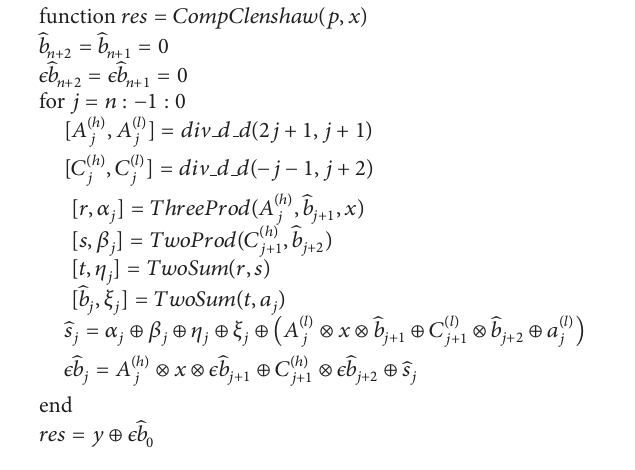
Algorithm 6: Compensated Clenshaw algorithm.